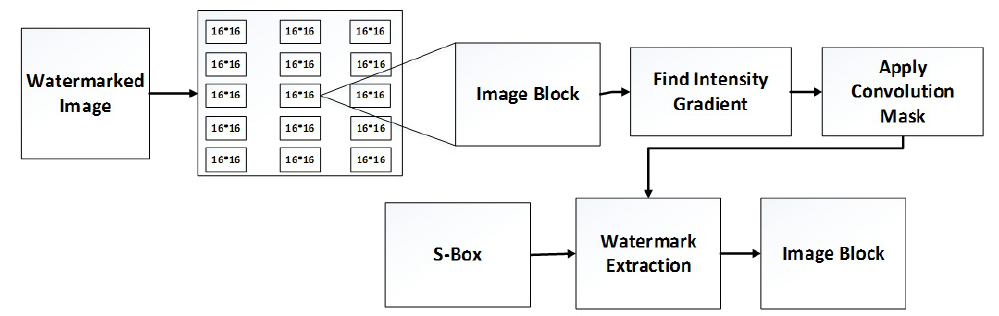
Figure 4. Watermark extraction flow